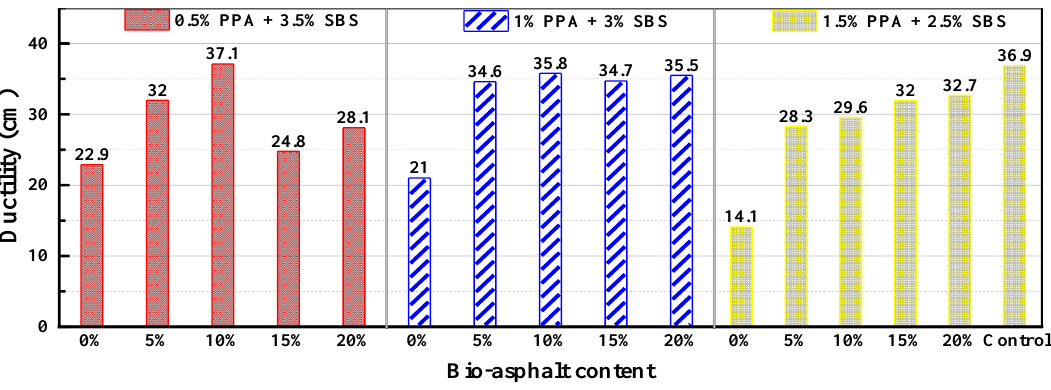
Figure 3. Test results for ductility.